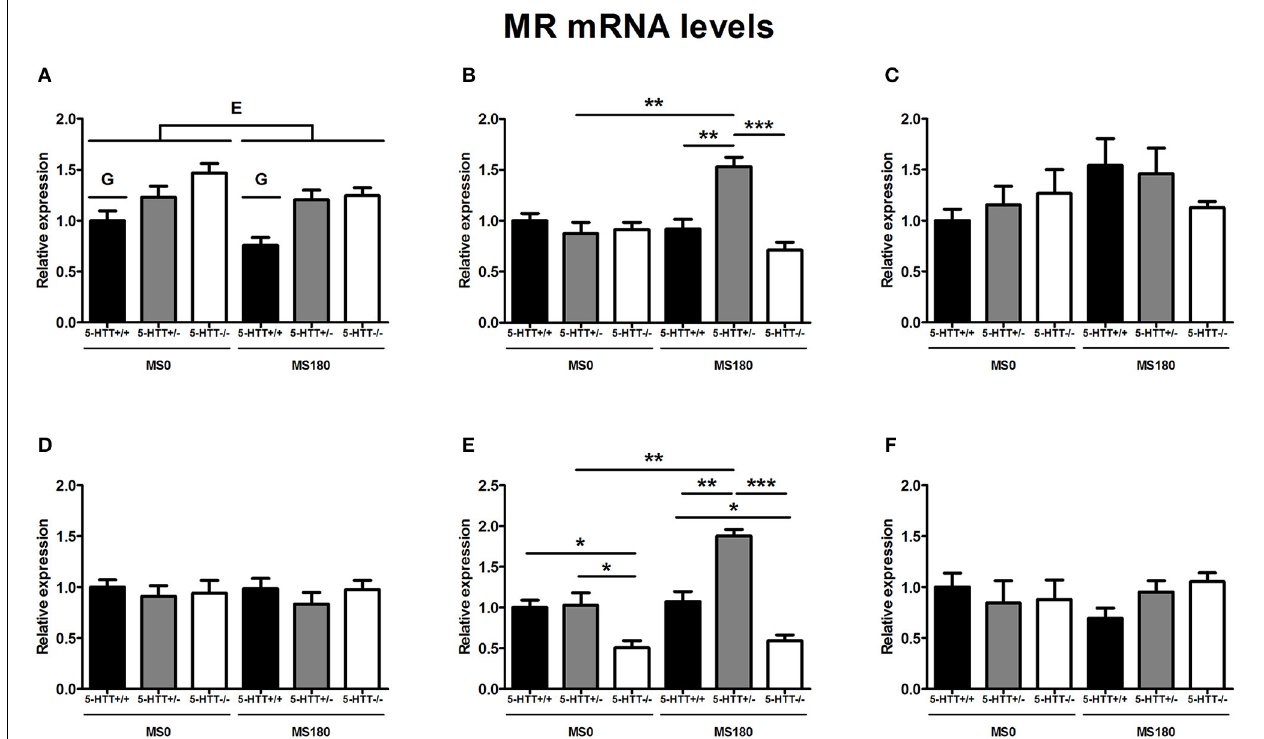
FIGURE 2 | Mineralocorticoid (MR) mRNA levels in the dorsal medial prefrontal cortex (mPFC) (A) dorsal hippocampus (B) central amygdala (C) ventral mPFC (D) ventral hippocampus (E) and the anterodorsal bed nucleus of the stria terminalis (F) of serotonin transporter (5-HTT) homozygous knockout (5-HTT − / − ), heterozygous knockout (5-HTT + / − ), and wild-type (5-HTT + / + ) rats exposed to daily 3h separations (MS180) or a control treatment (MS0). MR mRNA levels in the dorsal and ventral hippocampus were found to be affected by a significant interaction of early